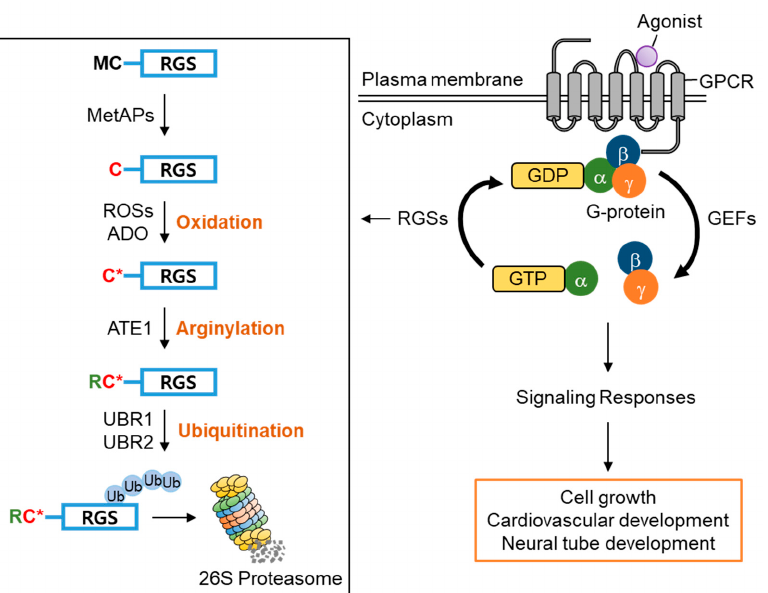
Figure 7. A model describing the regulatory role of UBR1 and UBR2 in G-protein signaling pathways via mediating RGS protein degradation. In GPCRs (G-protein-coupled receptors), heterotrimeric G- proteins are dissociated into G (cid:104) and G®© subunits by external ligands or signal mediators. Activated GTP-bound G (cid:104) and G®© stimulate the downstream signaling pathway associated with cell growth and cardiovascular development. The proper regulation of GTP-G α activity by GTPase-activating RGS proteins is vital in the GPCR-related signaling pathway. Among the RGS proteins, RGS4, RGS5, and RGS16 are cleaved by MetAP to expose a cysteine residue at the N-terminus. After which, these RGS proteins undergo oxidation, followed by arginylation (C* denotes the oxidized N-terminal Cysteine residue). Arginylated RGS proteins are recognized by UBR1 and UBR2 for ubiquitination and degradation. When the Arg/N-degron pathway is genetically inhibited, metabolically stabilized RGS proteins promote the hydrolysis of the GTP-bounded G (cid:104) subunit, which leads to inactivation of the GPCR signaling